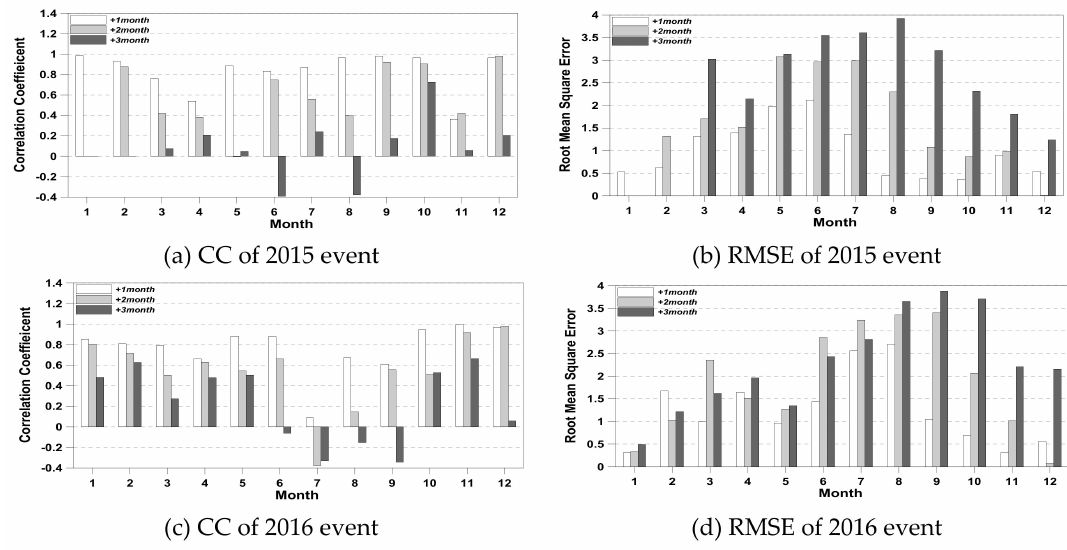
Figure 7. CC and RMSE of MSWSI(3) for 1 − , 2 − and 3 − month lead times in 2015 and 2016 events. The white bar, gray bar and black bar indicates MSWSI(3) for 1 − , 2 − and 3 − months lead times,